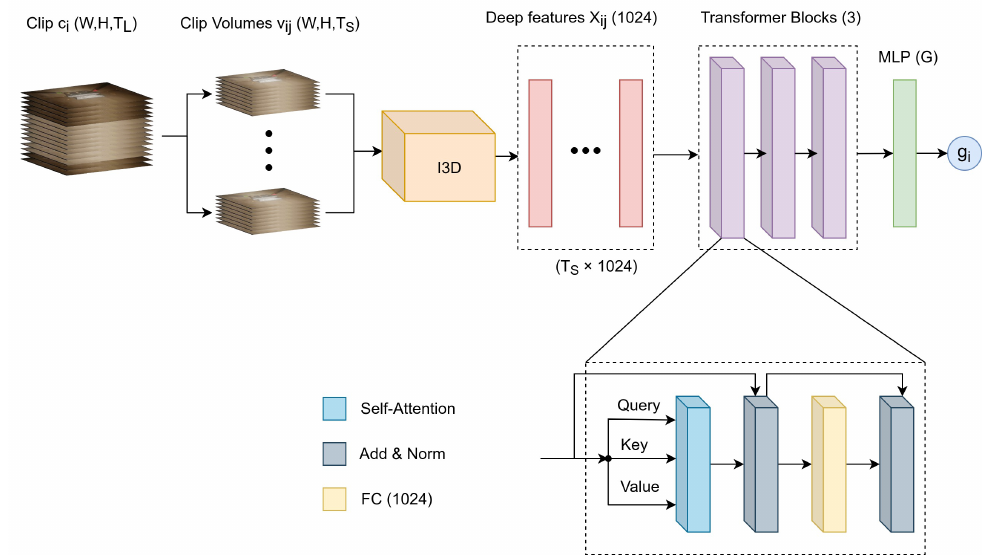
Figure 4. Overview of the transformer